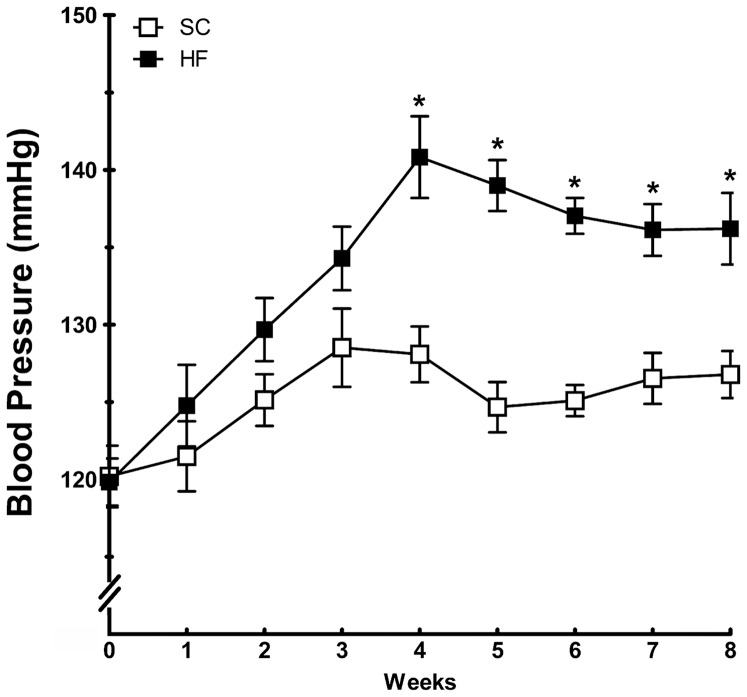
Systolic blood pressure evolution in mothers before pregnancy (mean and standard error of the mean).Significant differences (P<0.05) are indicated with an asterisk (n = 10 animals each group, unpaired t-test). Abbreviations: SC, standard chow group; HF, high fat diet group.